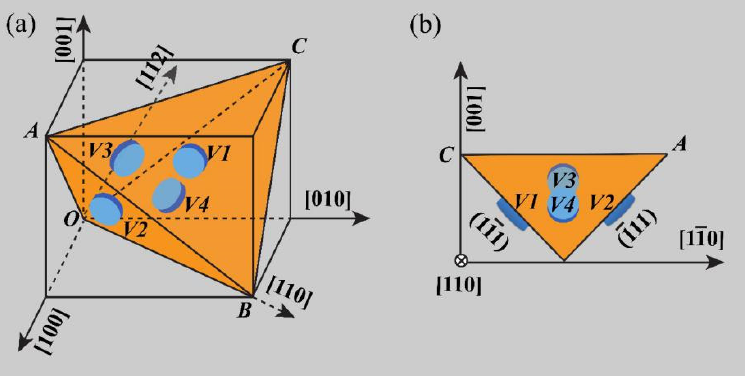
Figure 7. Schematic illustrations showing four types of η variants V 1-4 on {111} Al . ( a ) The three- dimensional view, and ( b ) the projection from [110] Al direction.